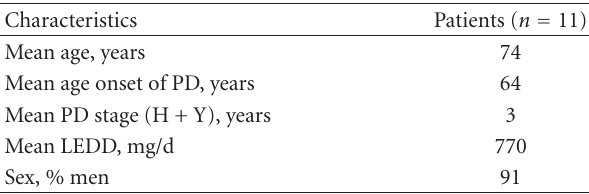
Table 1: Characteristics of